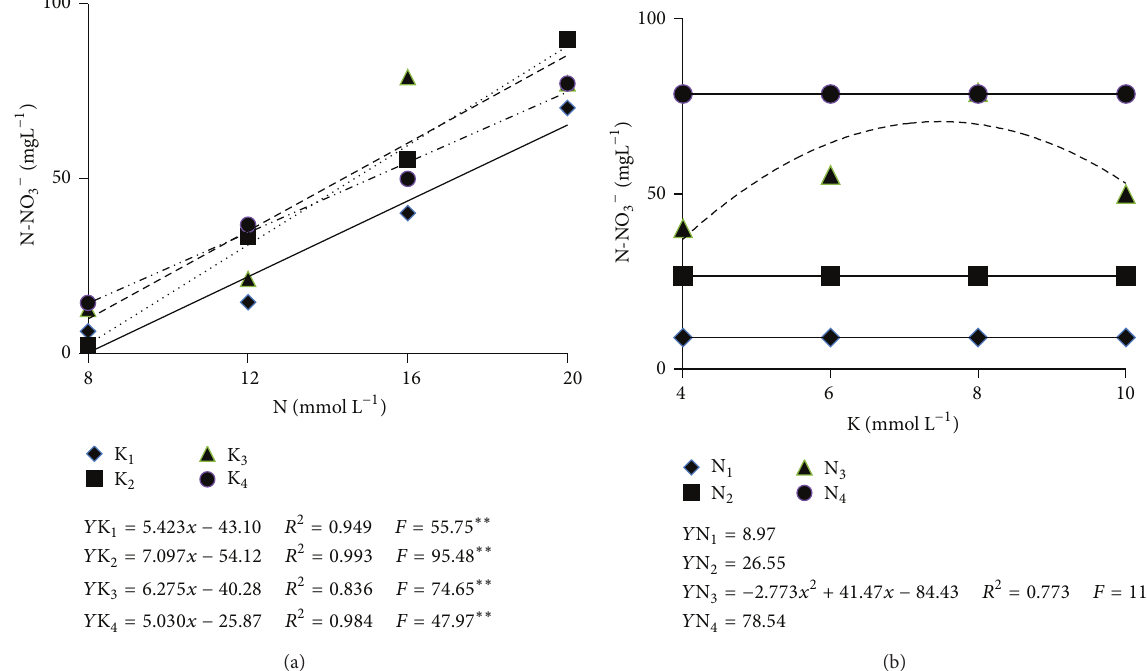
Figure 3: N-NO 3− levels (mgL −1 ) in the substratum solution extract (method 1:1.5v/v) 60 days after transplantation as influenced by the concentrations of N (a) and of K (b) in the nutrients solution. ∗∗ : Significant at the level of 1%, according to the 𝐹